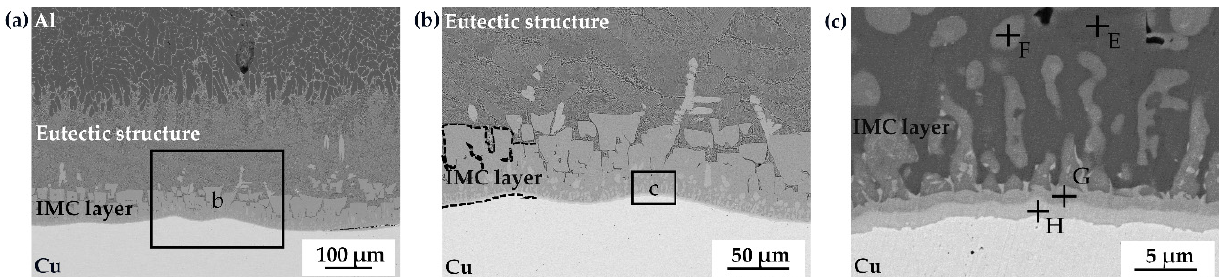
Figure 5. ( a ) BSE image of the interfacial region with a reaction layer, ( b , c ) highly magnified BSE image of an IMC layer located beside Cu in the Al/Cu dissimilar joint with the addition of 2.3 at.% Ni to the Al filler material. Table 4. Chemical compositions of the IMC phases formed with 2.3 at.% Ni indicated in Figure 5. Content (at.%) Location